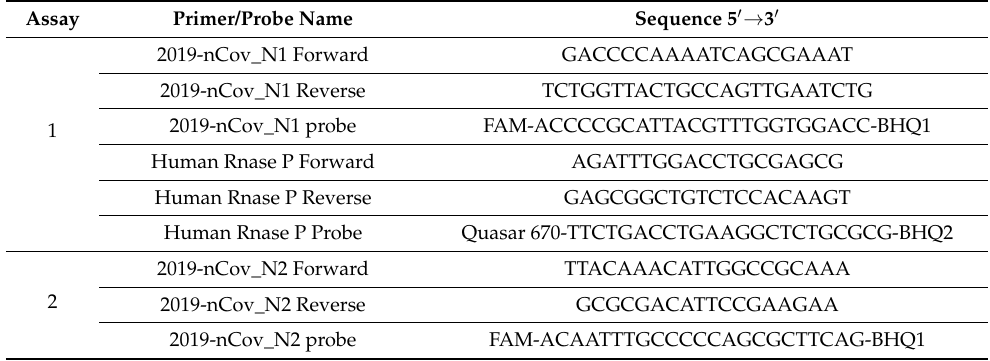
Table 1. List of primer and probe